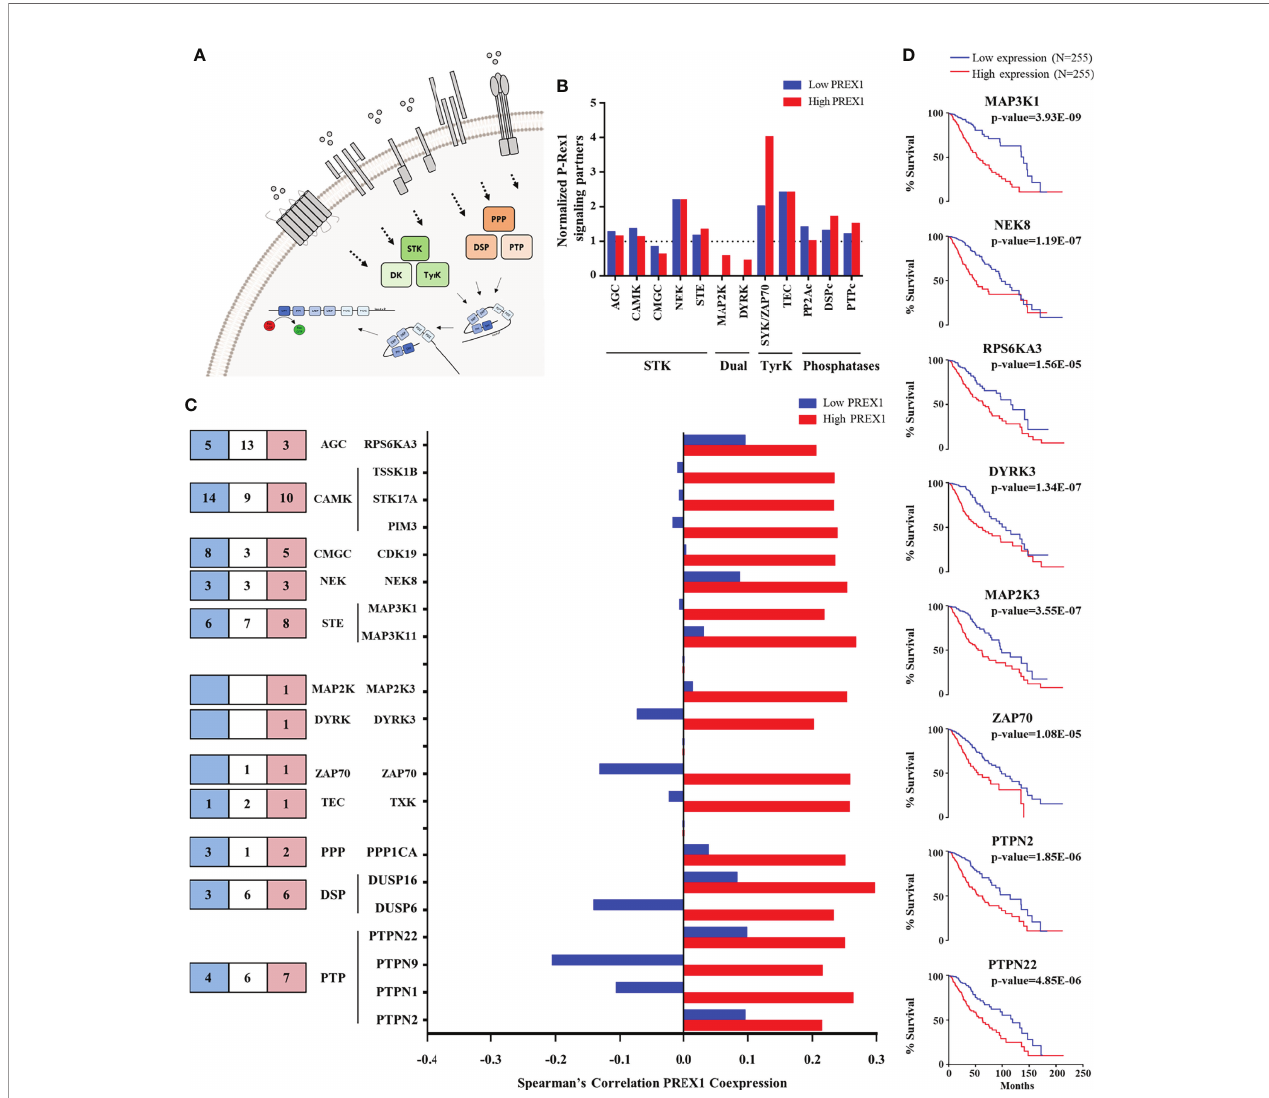
FIGURE 3 | Kinases and phosphatases highly coexpressed with PREX1 in LGG. (A) Model depicting serine/threonine kinases (STK), tyrosine kinases (TyrK) and kinases with dual speci fi city (DK) and phosphatases (PPP, PTP and DSP) potentially linked to P-Rex1 signaling. (B) Normalized coexpression with PREX1 and protein kinases and phosphatases within the top quartile of PREX1 coexpression list. A value of 1.0 indicates that the number of coexpressed genes in low and high PREX1 coexpression lists (blue and red), within the top quartile, equals one-fourth of the existing genes within the indicated group of signaling proteins. (C) Number of the indicated groups of kinases and phosphatases highly coexpressed with PREX1 only in the low (blue), high (red) or both (white) PREX1 coexpression lists (left). Those preferentially coexpressed with PREX1 within the high expression group (red bars) are indicated in the graph (right). (D) Overall survival curves based on the expression of protein kinases and phosphatases highly coexpressed with PREX1 (50:50 percentiles). Statistical signi fi cance was assessed by the Log-rank